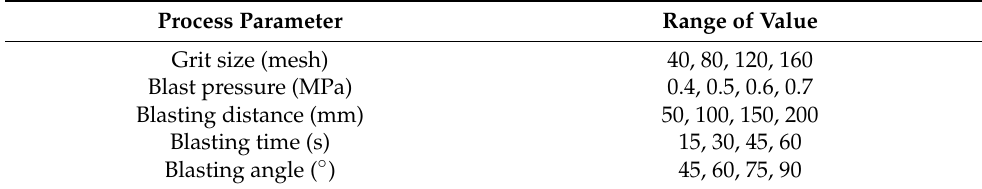
Table 1. Grit blasting process parameters and variation